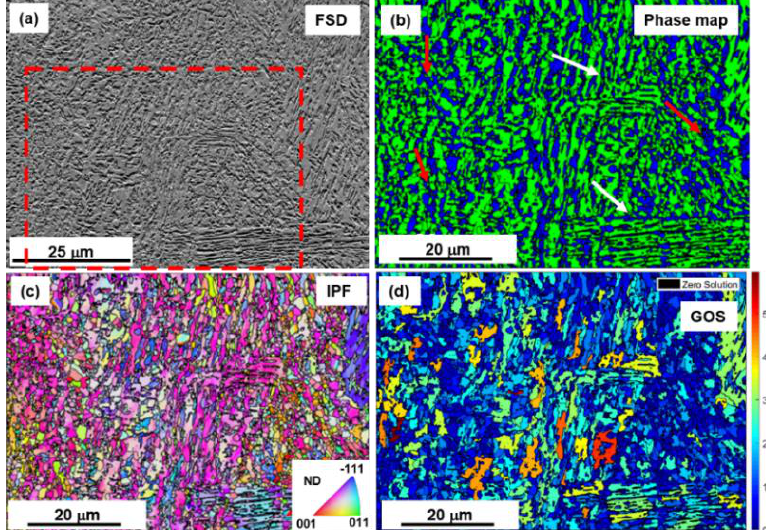
Figure 2. Electron backscatter diffraction measurement of initial microstructure in austenite-reverted-transformation annealed specimen, including ( a ) forescatter diode image, ( b ) phase distribution map, ( c ) inverse pole figure and ( d ) grain orientation spread image. The dashed box in ( a ) denotes the analyzed region for ( b – d ); red arrows in ( b ) indicates globular grains; white arrows marks the band-shaped lamellar grains.